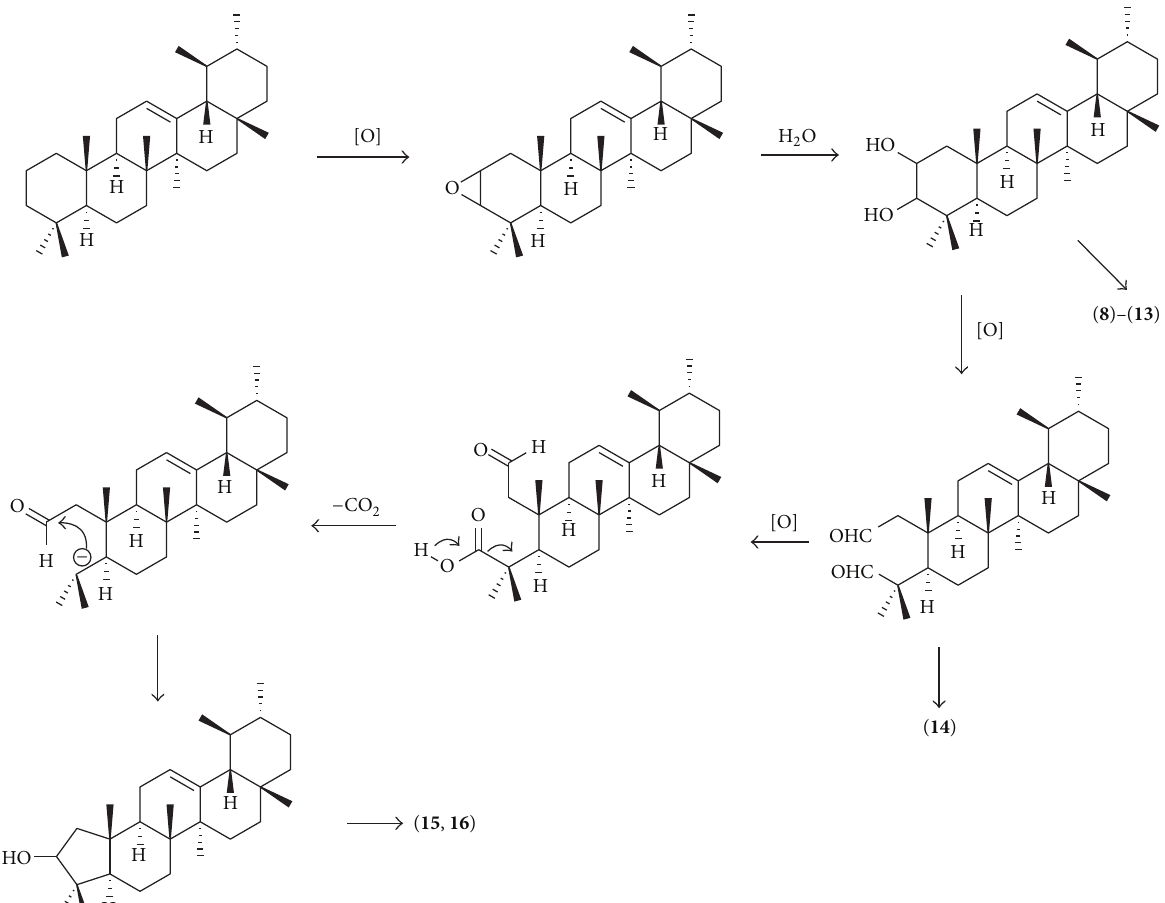
Scheme 1: Proposed biosynthesis of compounds 8 – 16